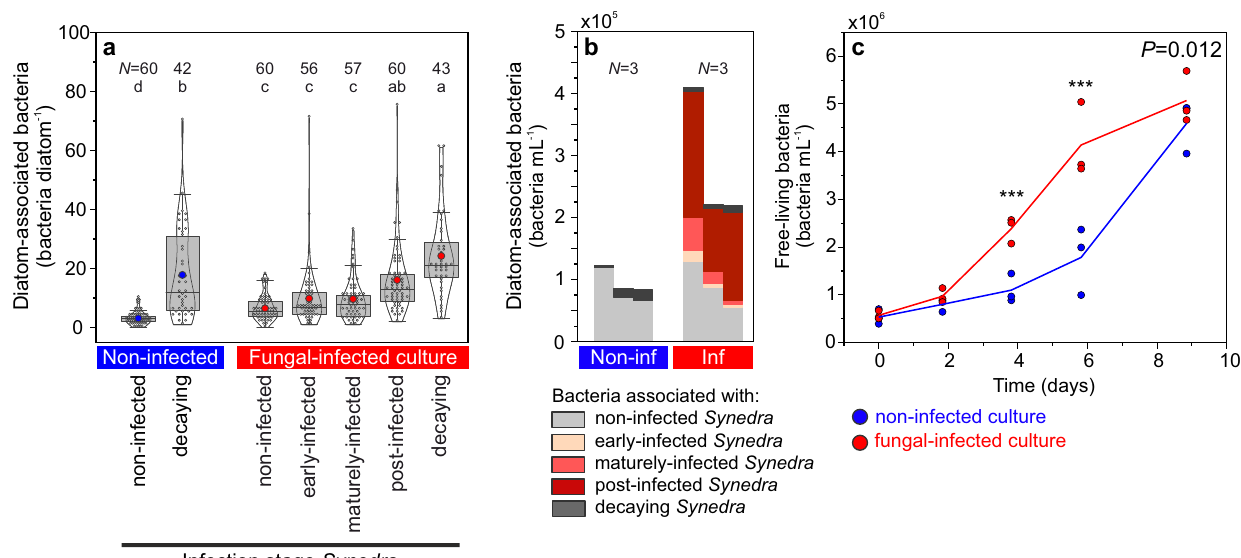
Fig. 3 Bacterial abundances in the diatom – fungus co-cultures. Abundances of diatom-associated bacteria are shown per individual Synedra cell ( a ) and per culture volume ( b ) on day 9. Bacteria were grouped based on their association with individual Synedra cells of different infection stages. The letters a – d in ( a ) denote signi fi cantly different groups (Kruskal – Wallis, P < 0.05, N = numbers of analyzed Synedra cells). Data are shown as single data points (white- fi lled circles), the 25th, 50th, and 75th percentile (grey boxes), mean values (blue and red- fi lled circles), and distribution curves (kernel smoothing). Data from the previous sampling days 0 – 6 are listed in Supplementary Data 2. Stacked bars in b represent individual sample replicates. c Abundances of free- living bacteria. Single data points are plotted as circles and lines connect mean values over time (symbols of mean values are not displayed). Time series data of free-living bacterial abundances were signi fi cantly different between both treatments ( P = 0.012, GLMM, F 4,16 = 4.591). Blue and red items represent data from the non-infected and fungal-infected cultures, respectively. Statistically signi fi cant differences at single time points are indicated with asterisks ( *** P < 0.001). b , c N = 3 incubation fl